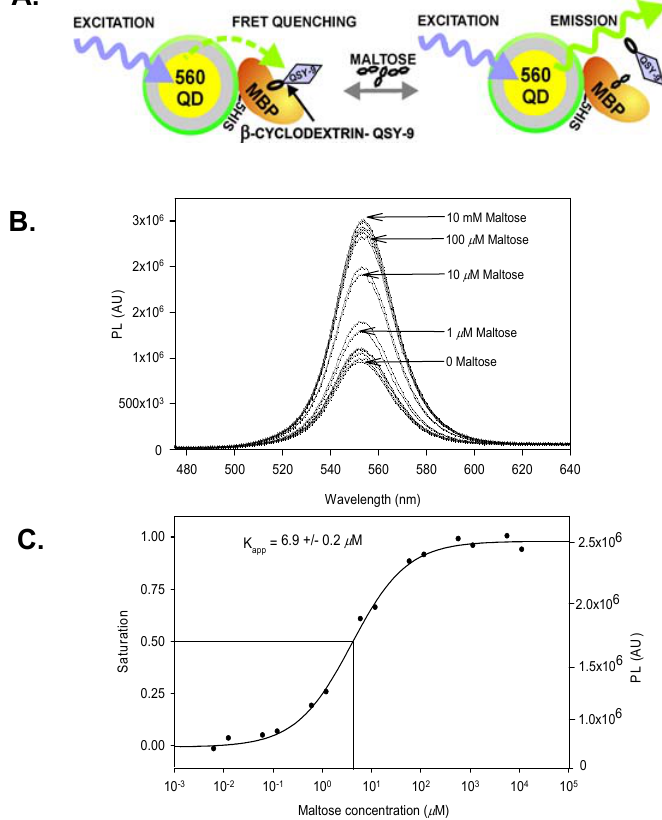
Figure 6. Function of a QD-Maltose Binding Protein FRET Nanosensor. A. Each